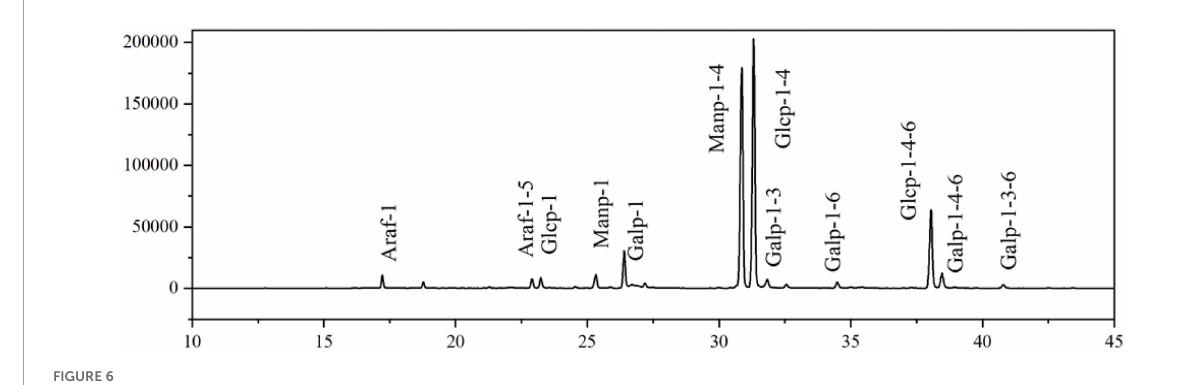
FIGURE6 Total ion chromatogram of the methylated production of EFP-2.